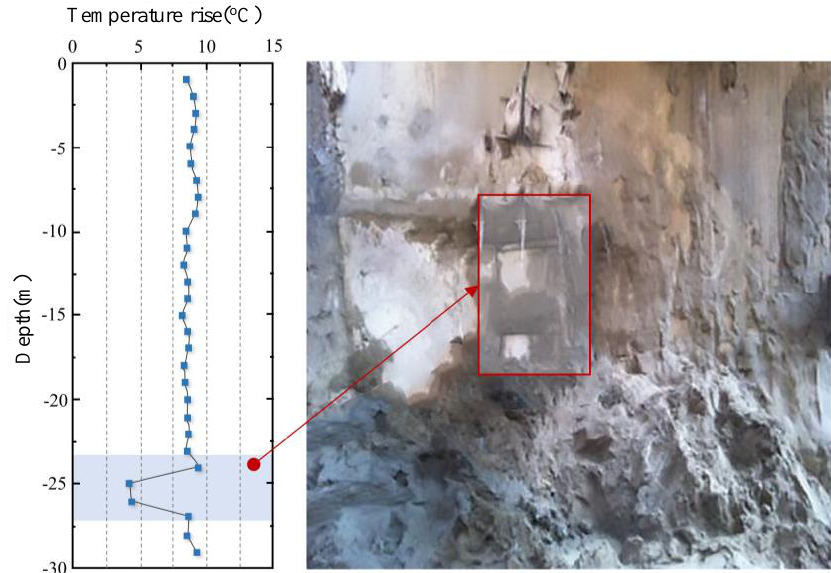
Figure 3. Field test results of fiber optic temperature measurement system.